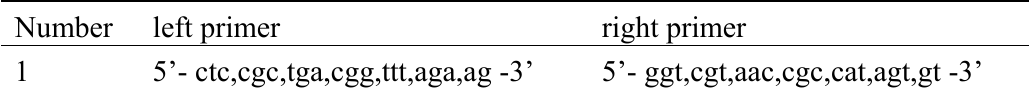
Table 3. Two pairs of unique primers of SRBSDV